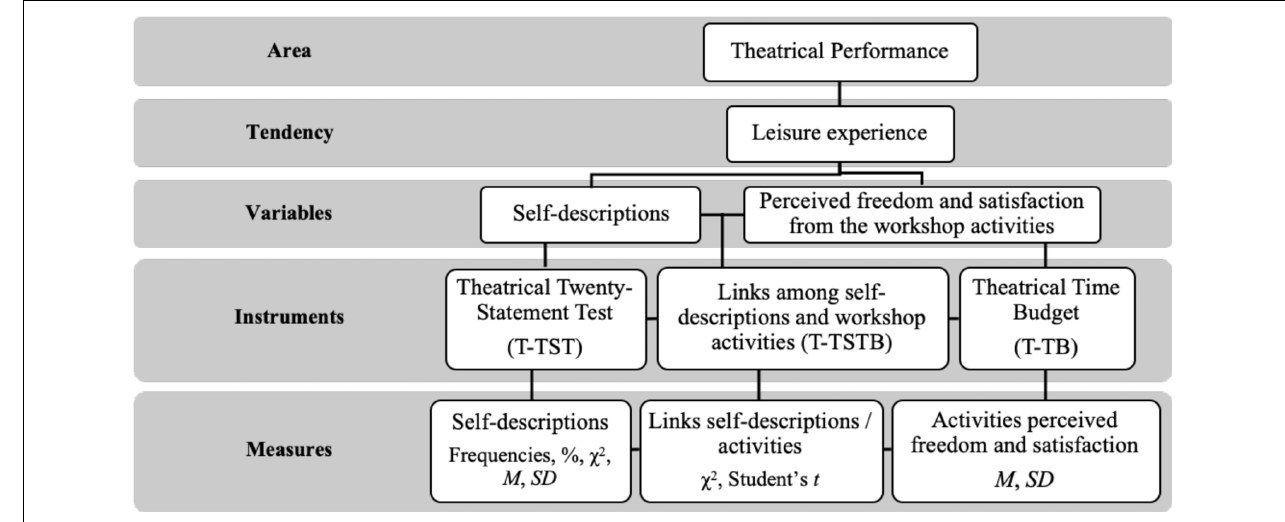
FIGURE 2 | Main characteristics of the empirical study. Source: prepared by the